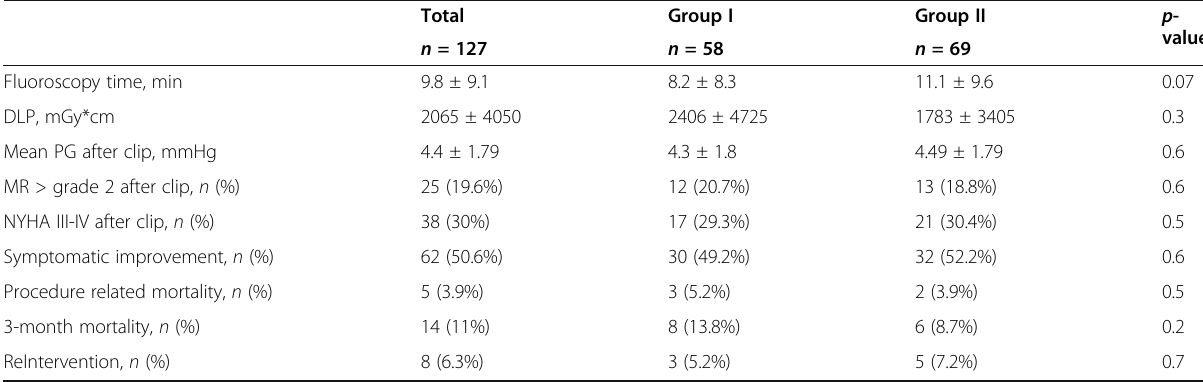
Table 3 Procedural and post-procedural characteristics